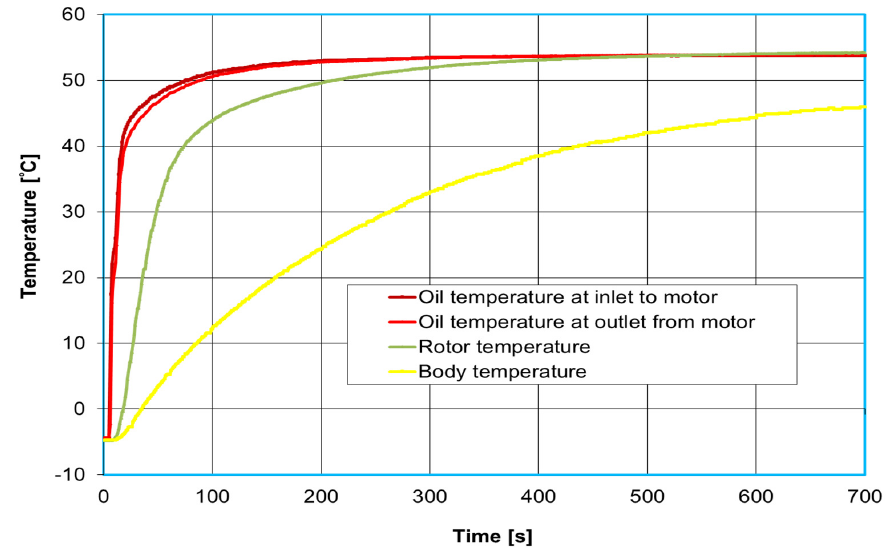
Figure 17. Characteristics of the temperatures of the rotor, body, and oil at the inlet and the outlet of the motor as a function of time (ambient temperature (motor) –4 °C, rotational speed in steady-state conditions 185 rpm).